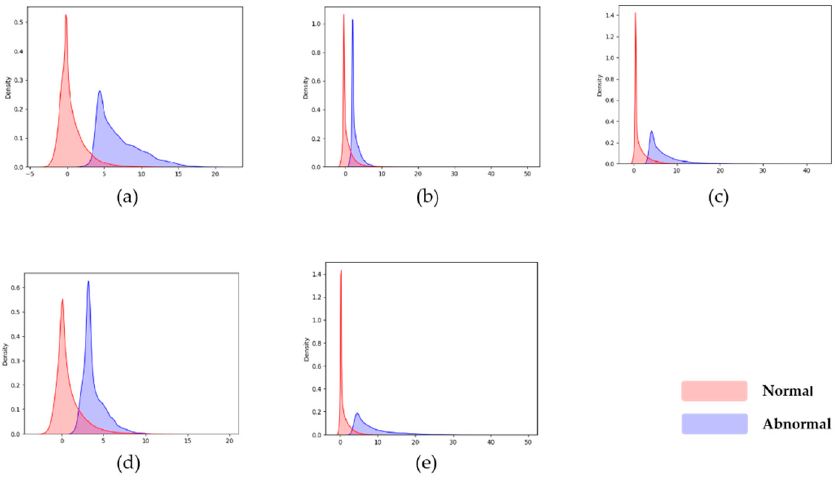
Figure 8. Score distribution of the first five accelerometers, the x -axis represents the score, and the y -axis represents the density of the score distribution. ( a – e ) represent accelerometer 1 to 5.